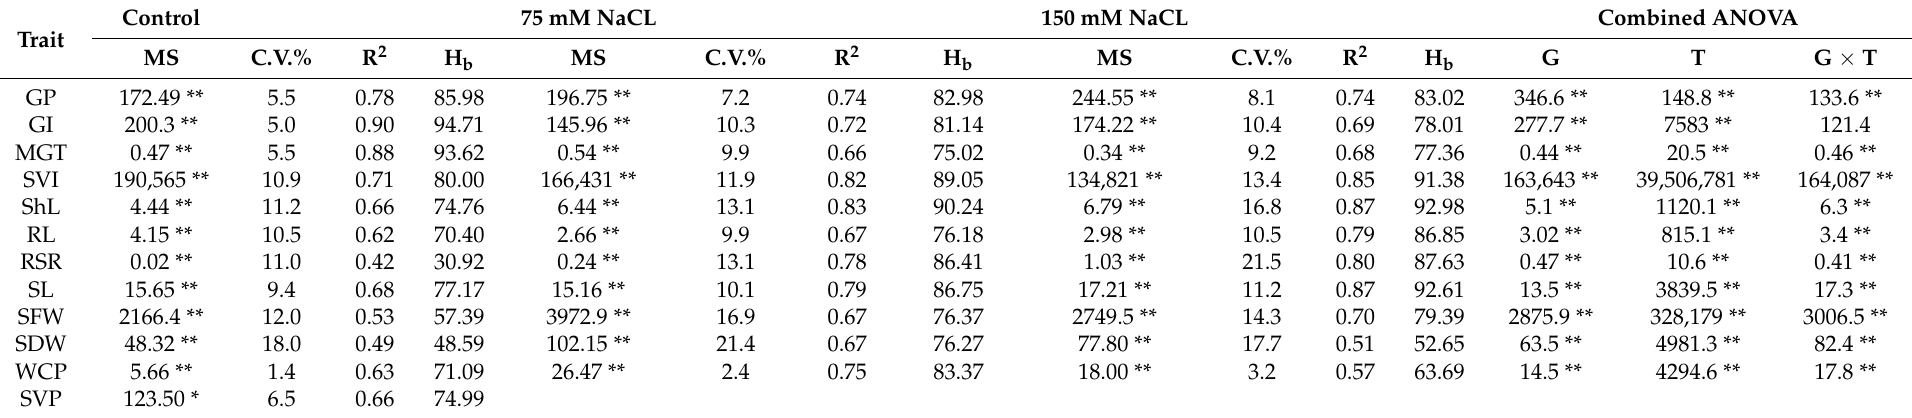
Table 1. Separate and combined ANOVA, coefficient of variation (C.V.%), coefficient of determination (R 2 ), and broad-sense heritability (H b ) for the investigated traits in the current study.